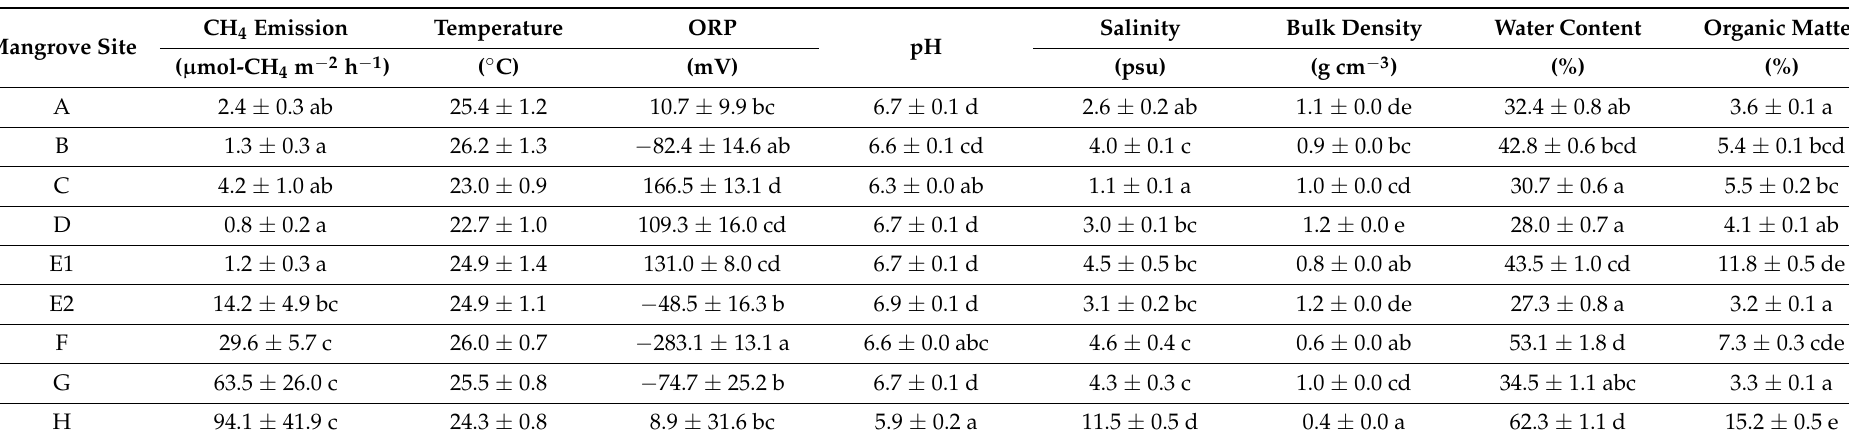
Table 2. CH 4 emissions and soil characteristics (mean ± standard error) of the mangroves at A—Wazihwei (WZ); B—Zhuwei (ZW); C—Xinfeng (XF); D—Zhunan (ZN); E1—Fangyuan Kandelia obovata (FY-K); E2—Fangyuan Avicennia marina (FY-A); F—Budai (BD); G—Beimen (BM); H—Chiku (CK). Different letters represent significant site differences according to the Kruskal–Wallis test and Dunn’s test at the significance level. ORP—redox potential.